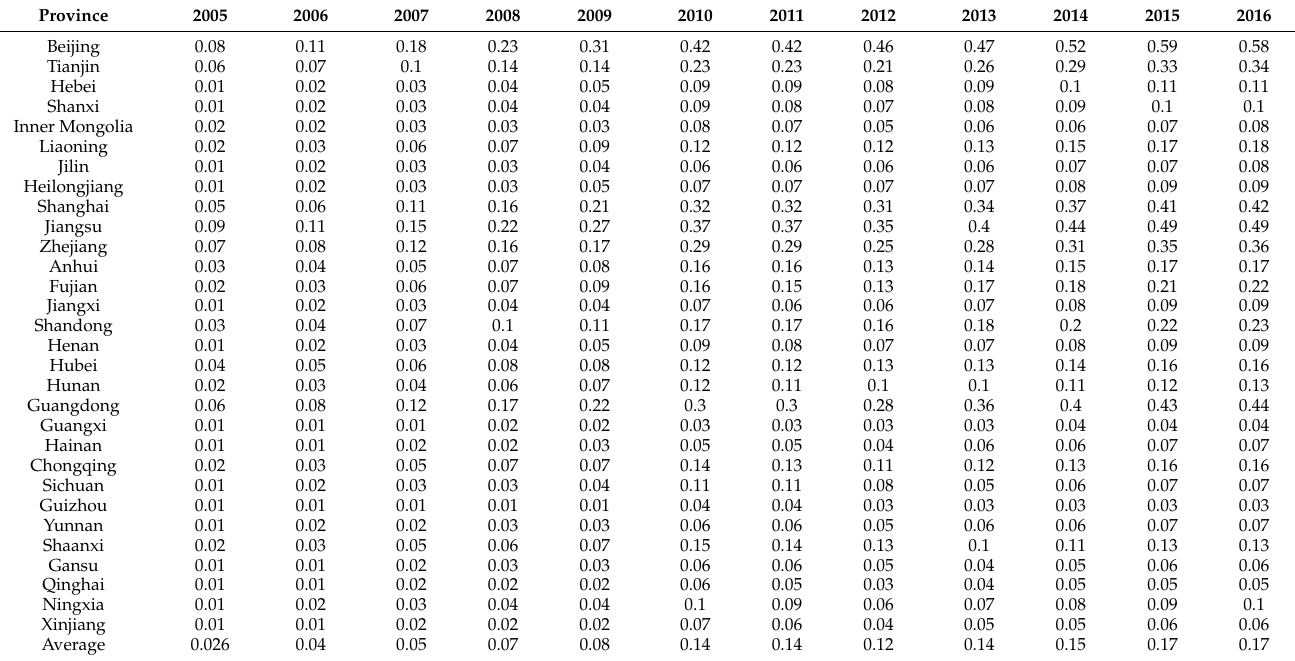
Table 4. The comprehensive development levels of technological innovation.